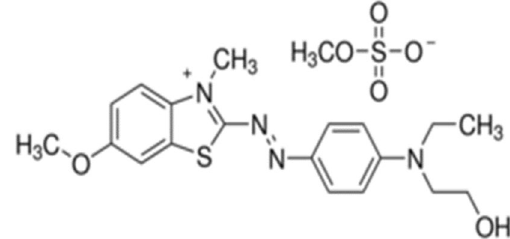
Fig. 1 Structural formula of BB41